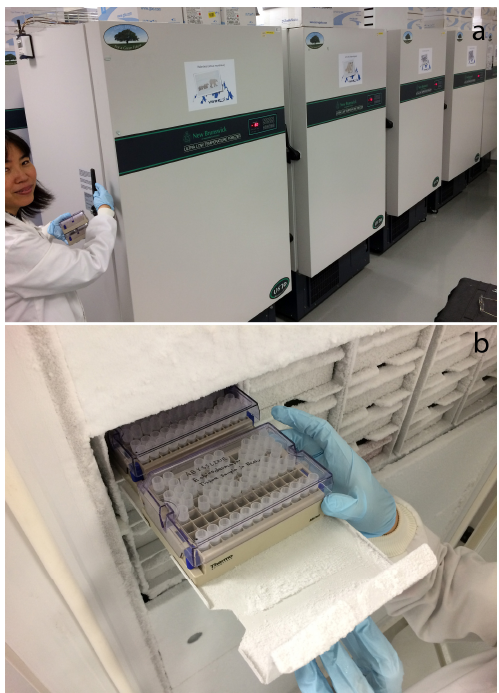
Figure 18. Data and sample management workflow on the ABYSSLINE DNA taxonomy project. Physical research-lab based samples are represented by light green boxes, physical institutionally-accessioned samples by grey ovals, institutional data by dark green boxes and externally-available data by blue ovals.